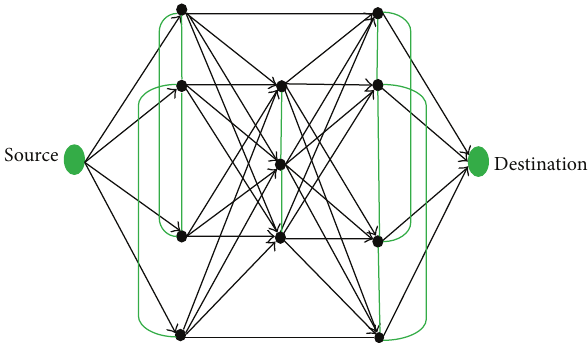
Figure 2: 16 × 16 IAON.